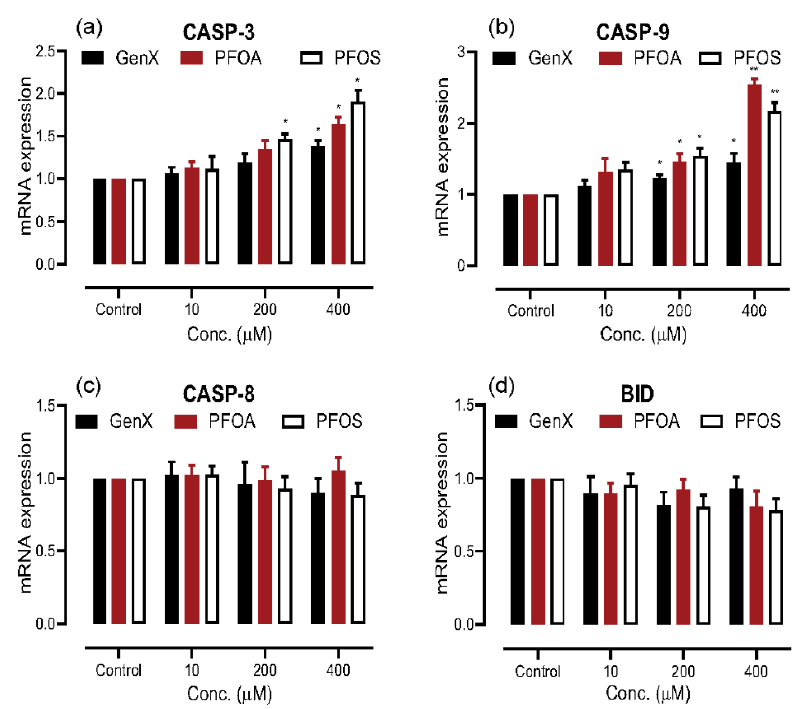
Figure 5. Identification of the apoptosis pathway taken by A549 cells on exposure to GenX, PFOA and PFOS. ( a , b ) Dose-related increase in the mRNA expression of caspase (CASP)-3 and CASP-9, respectively, for all the compounds. ( c , d ) mRNA expression of CASP-8 and BH3 interacting-domain death agonist (BID), respectively, showing no statistically significant change on exposure to any concentration of all the compounds. The results are presented as the mean ± S.D. for three independent experiments (n = 3) (* = p < 0.05, ** = p < 0.005) .